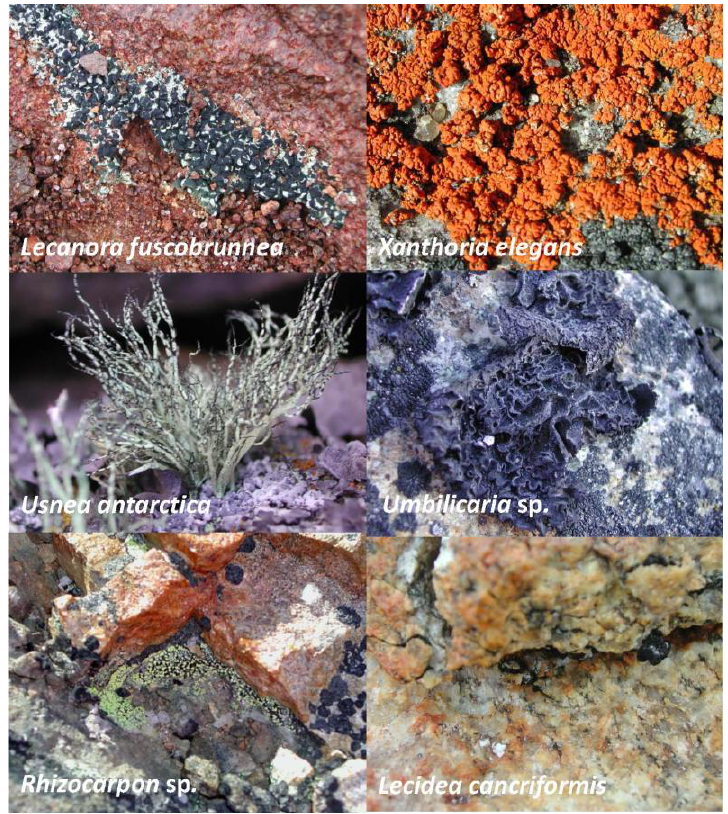
Figure 1. Some of the lichen thalli examined for black fungi.